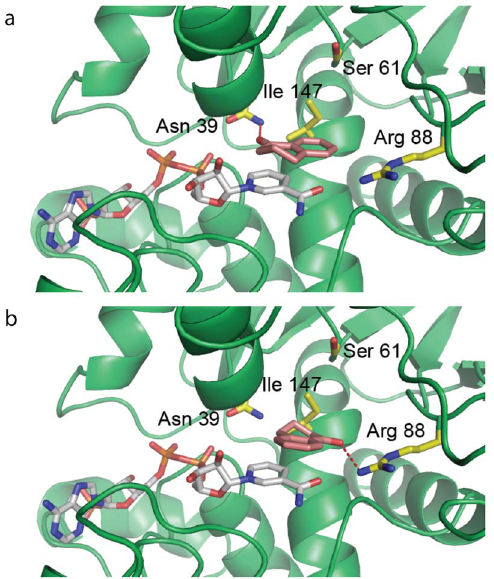
Figure 8. Binding interaction of a -tetralone in the substrate binding site of PyAeADHII/NADPH predicted by AutoDock. a) Binding mode 1, a -tetralone was positioned on top of the nicotinamide ring as a stacking interaction, and the oxygen atom formed a H- bonding interaction with the side chain of residue Asn-39 (3.5 A˚). b) a - tetralone again forms stacking interaction with nicotinamide ring, but the oxygen atom was orientated towards residue Arg-88 forming a H- bonding interaction (3.0 A˚). PyAeADHII is shown as a cartoon (green) and residues in the substrate binding site are shown as sticks (carbon colored in yellow, nitrogen in blue, oxygen in red). NADPH (carbons are in grey) and the substrate a -tetralone (carbon are in orange) are shown as